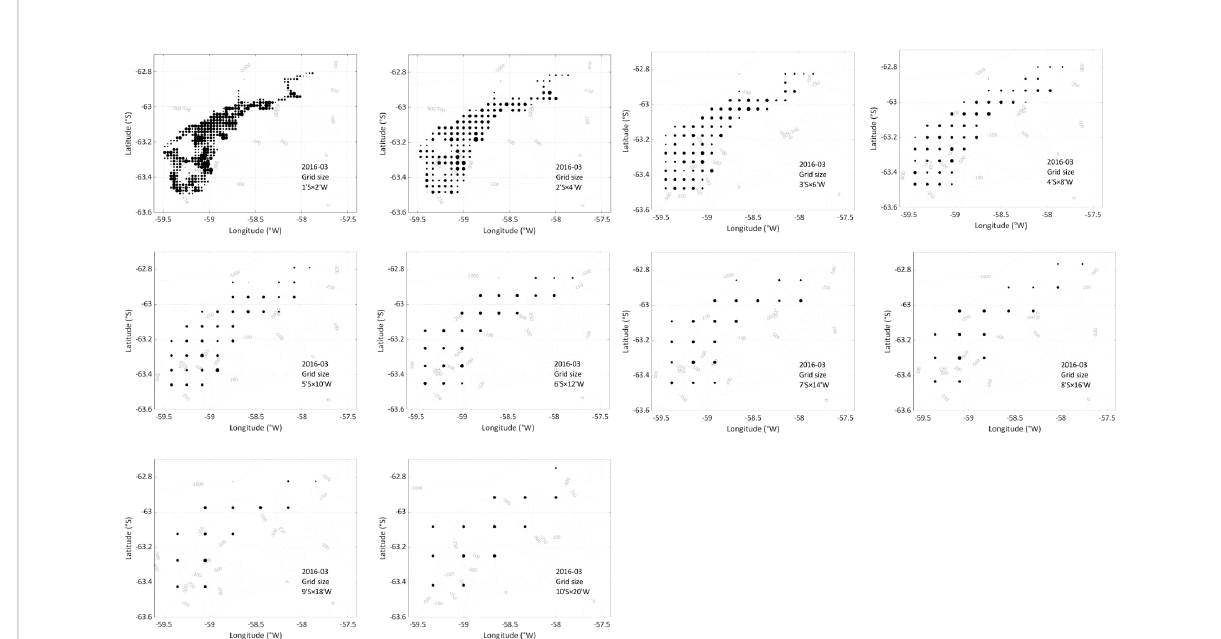
FIGURE 3 The scatter distributions of acoustic density for different grid sizes in February 2016. Circle diameter is proportional to krill density.